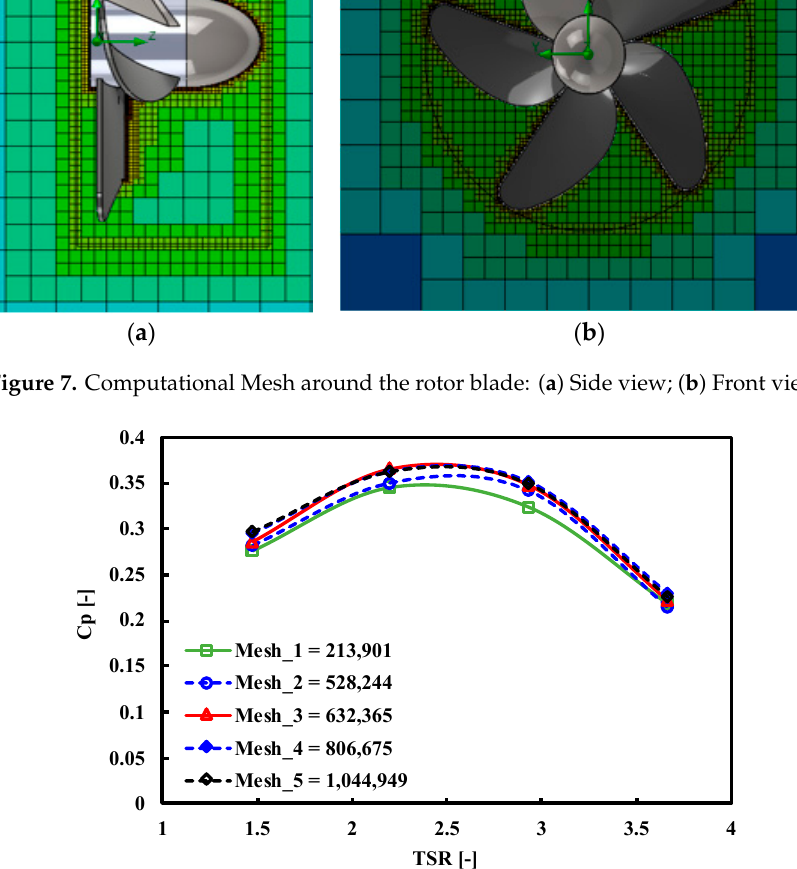
Figure 7. Computational Mesh around the rotor blade: ( a ) Side view; ( b ) Front view . Table 2. Meshing and boundary conditions.